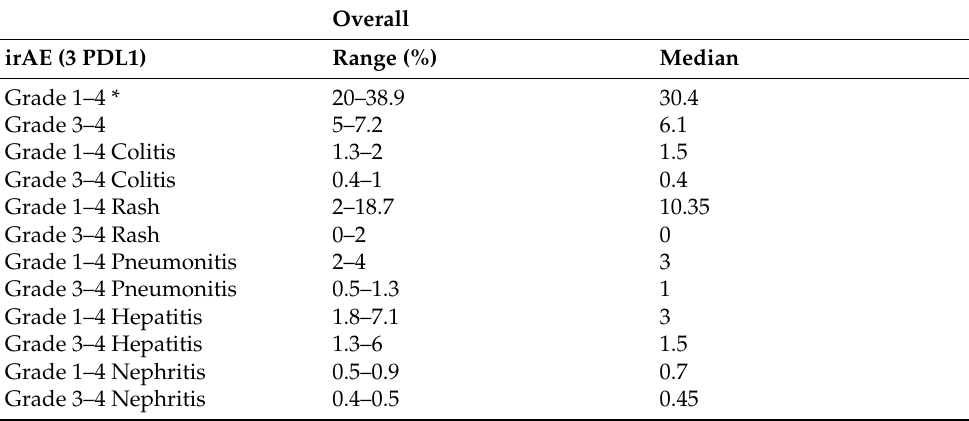
Table 2. Immune-related adverse events. Data from CASPIAN D, D+T (not available), IMpower133, and KEYNOTE-604. CA-184-156. PD-1/PD-L1, programmed death (ligand)-1.